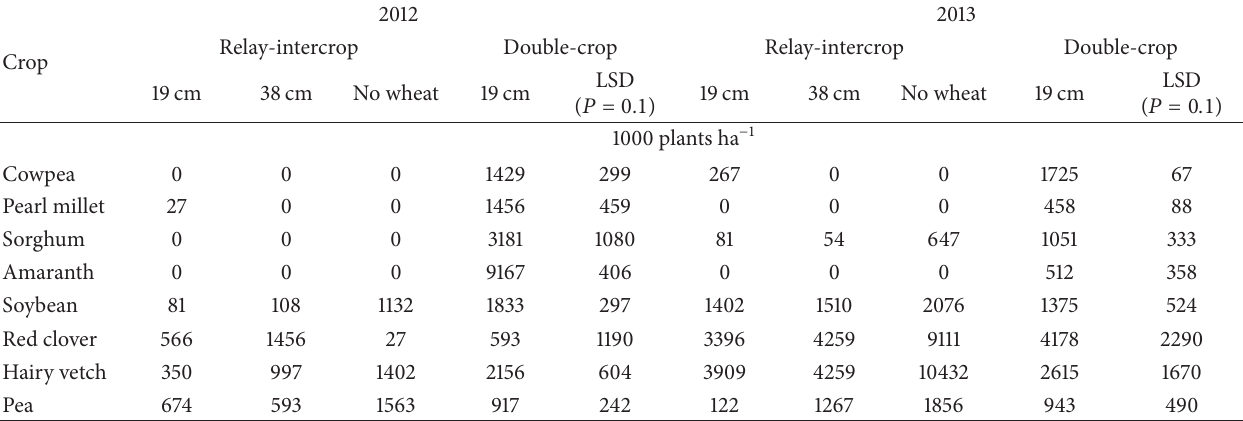
Table 3: Alternative crop emergence in intercrop and double-crop systems on 17 May, 2012, and 5 June, 2013.